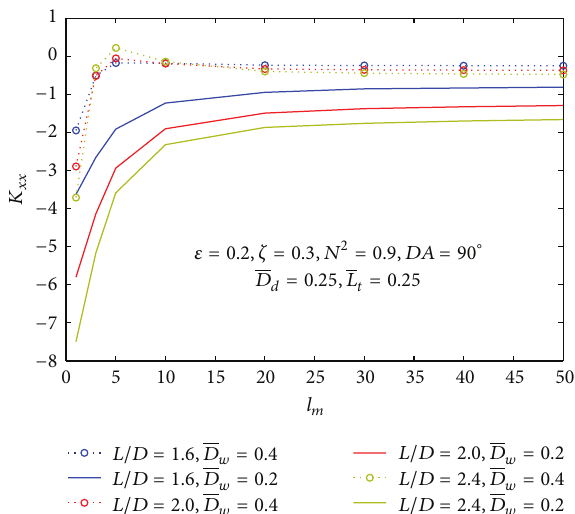
Figure 5: Variation of K 𝑥𝑥 as a function of characteristics length .” “ l m